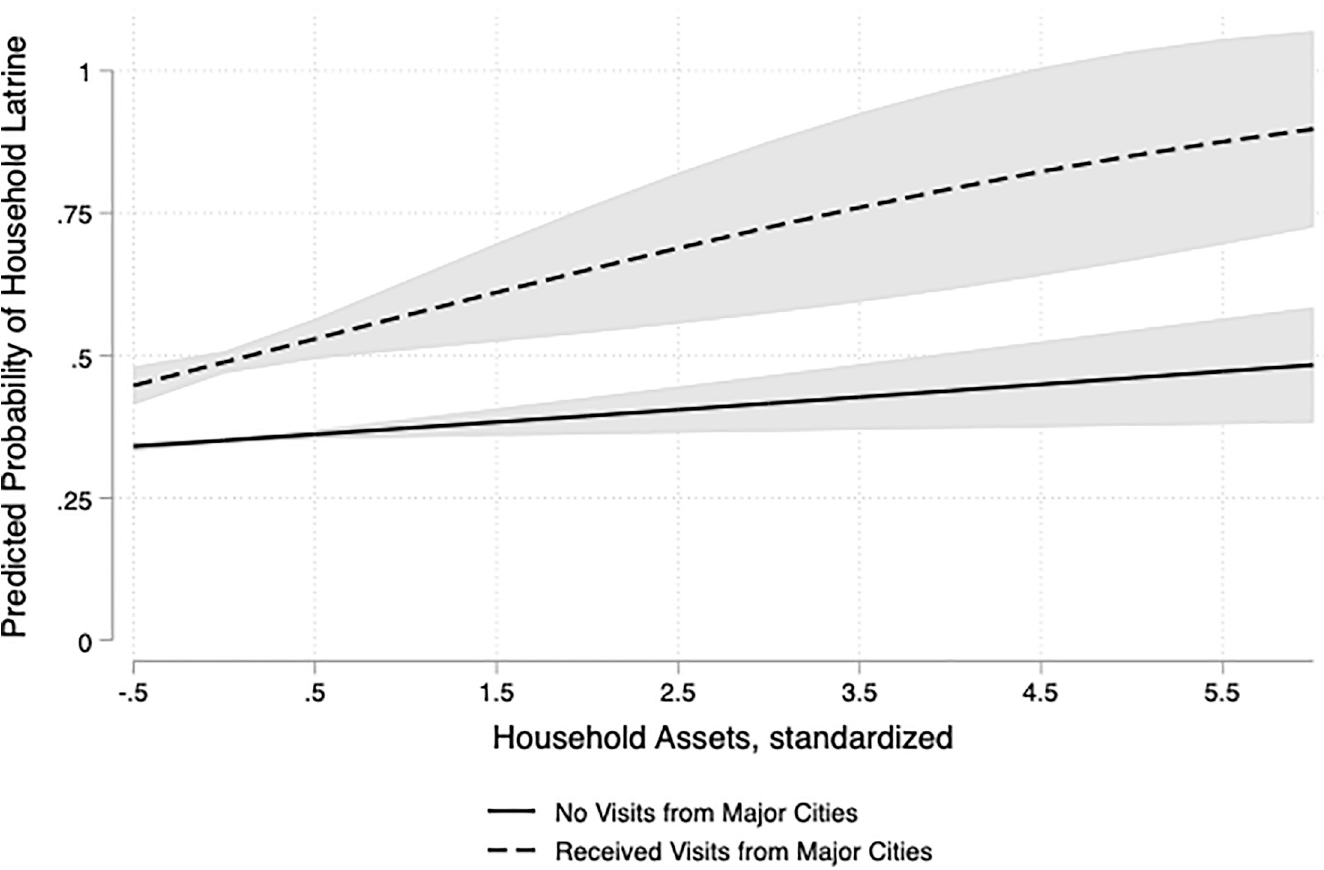
Fig 2. Predicted probability of having a latrine by family visits from major cities and assets: Interaction effect between family visits from major cities and assets. Interpreting interaction in Model 3. Predicted probabilities for households receiving visitors from major cities and those that did not and 95% confidence intervals. Group differences are significant (p < 0.05) for each level of household